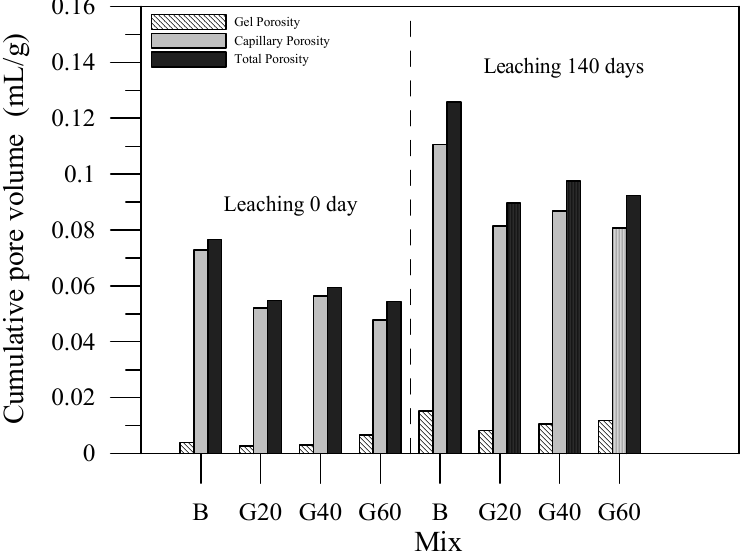
Figure 20. Porosity distribution of the specimens with slag admixture.